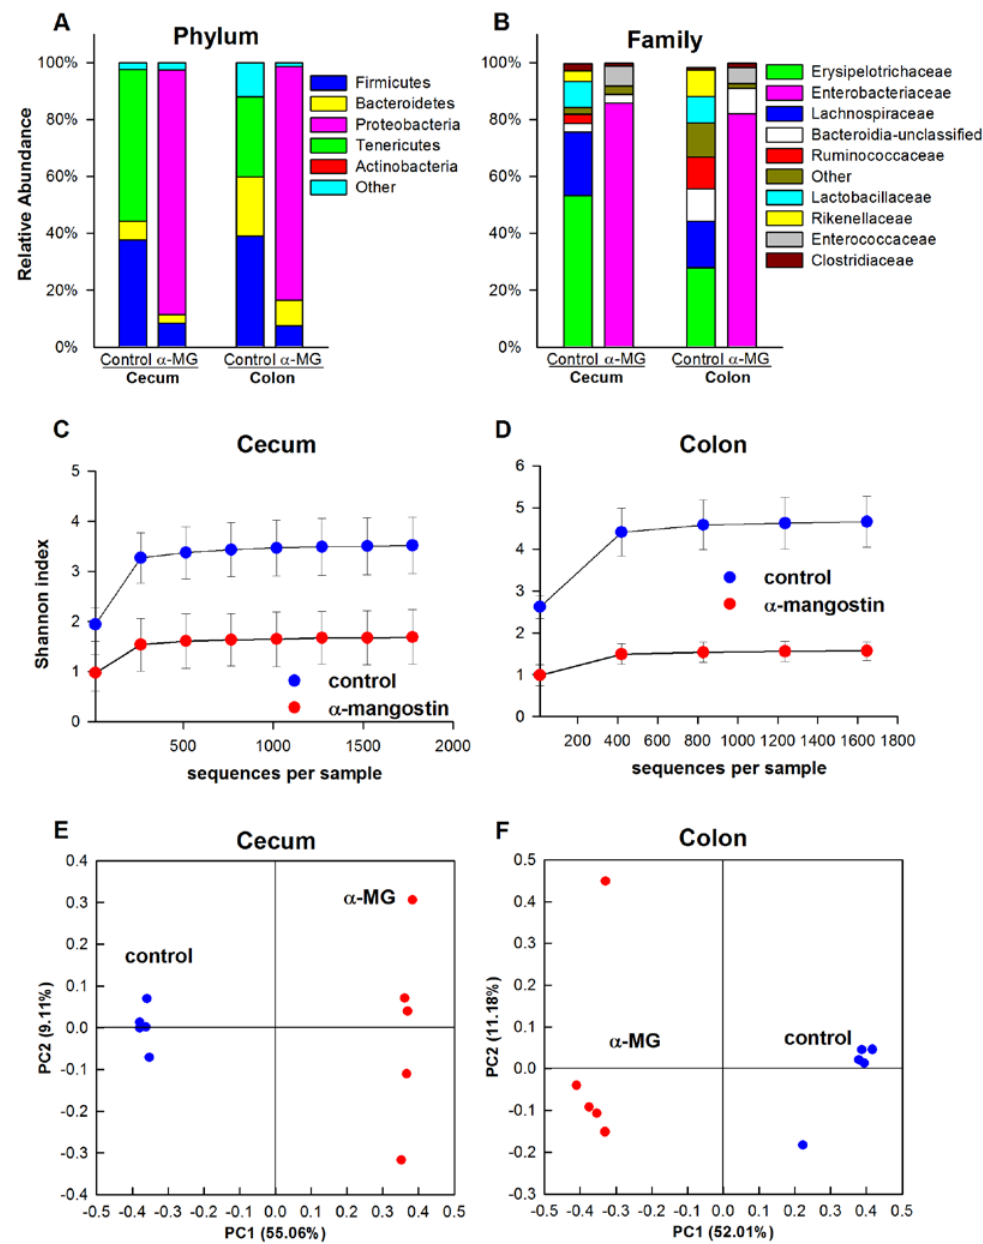
Figure 3. Induction of dysbiosis in C57BL/6J mice fed a diet containing α-MG. Dietary α-mangostin (α-MG) changes the relative abundance of bacterial communities in the cecum and colon of C57BL/6J mice at the ( A ) phylum and ( B ) family levels. Mice fed α-MG had significantly lower α-diversity in ( C ) cecum and ( D ) colon compared to mice fed control diet. Panels E and F show principal coordinate analysis (PCoA) for cecum and colon, respectively. Samples in the α-MG group (red) cluster together and away from those in control group (blue). Data are for tissues from 5